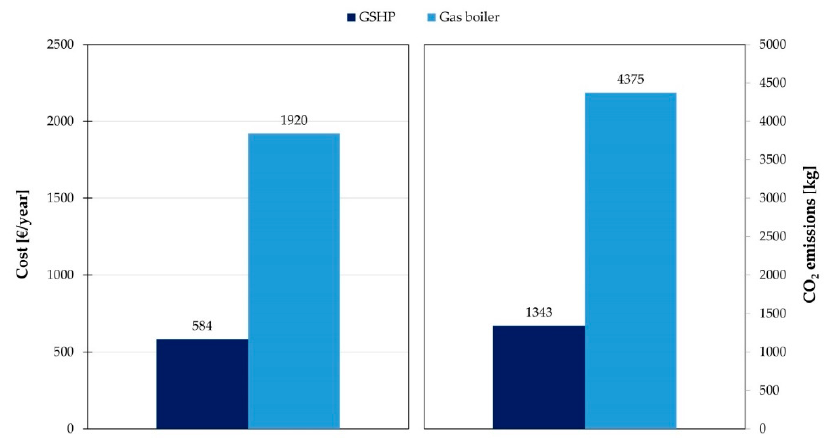
Figure 13. Building annual savings for space heating operation costs and CO 2 emission with the ground source heat pump system compared to the gas boiler.